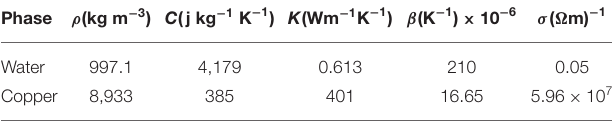
TABLE 1 | Numerical values of thermal properties of copper and water.